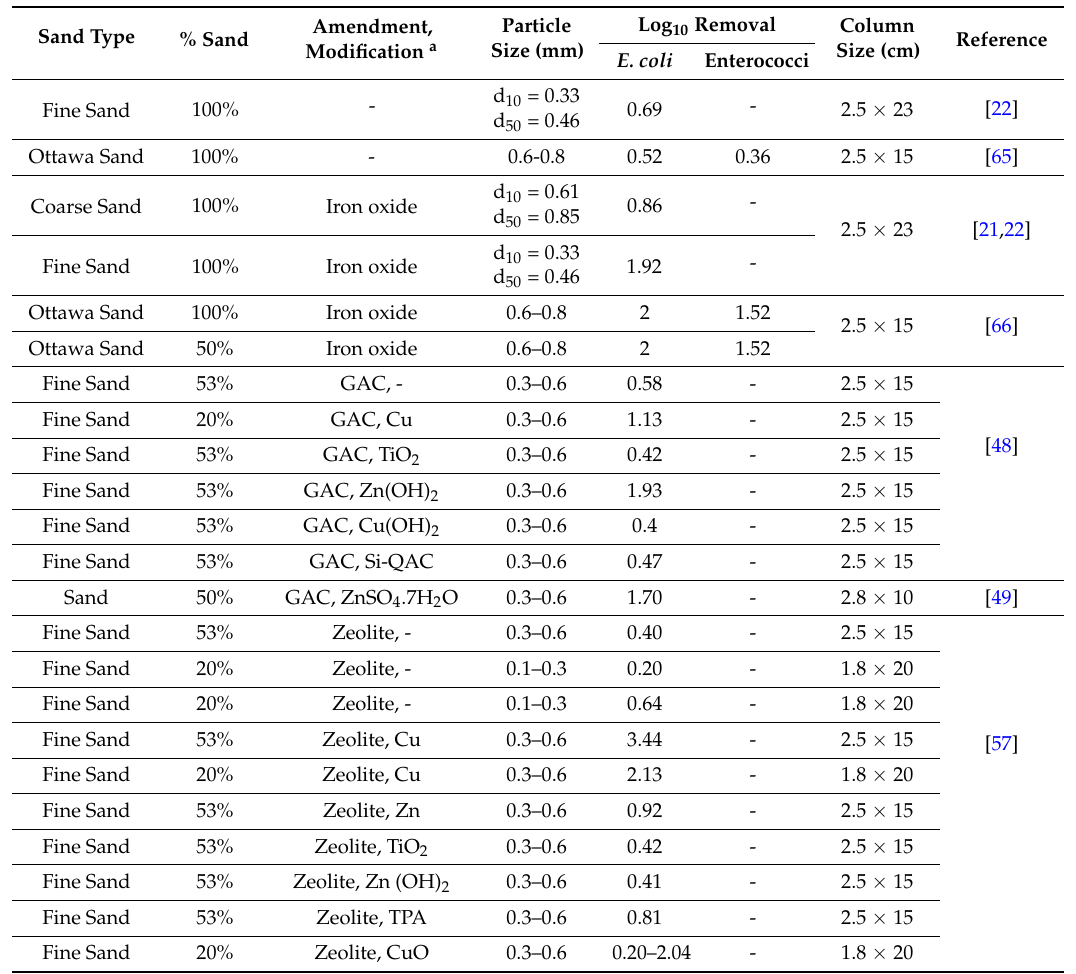
Table 2. Fecal indicator bacteria removal in sand biofilters with or without amendment (GAC: granular activated carbon, Zeolite), with or without various surface modification of the sand or of the